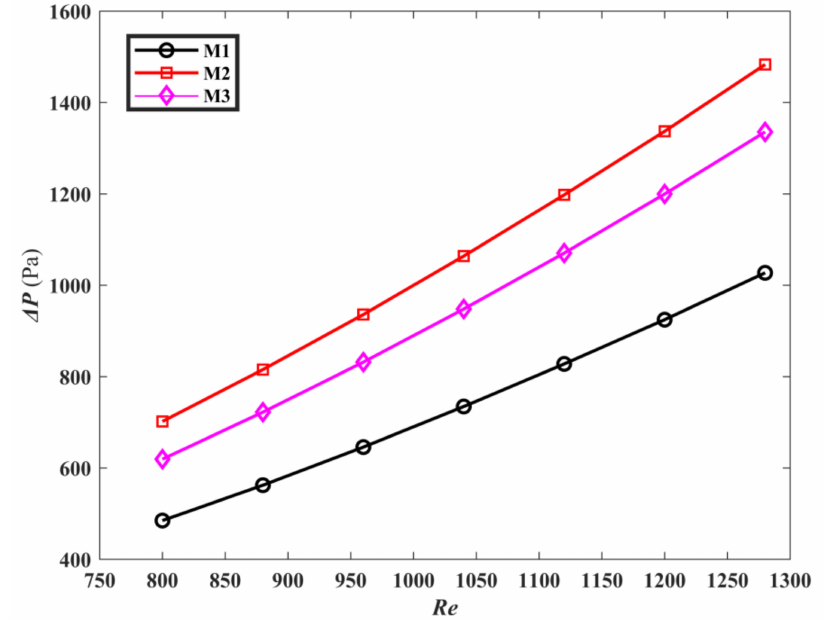
Figure 7. The ∆ P of the three mini-channels varies with Re .